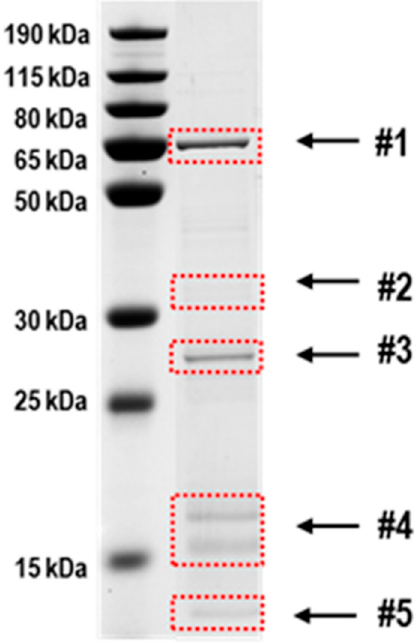
Figure 6. SDS-PAGE profile of the captured proteins by AbxC-affinity chromatography. AbxC was immobilized on CNBr- activated Sepharose 4B resin, incubated with D. radiodurans cell lysates, and washed with NaCl-containing buffer. Proteins captured by AbxC were released by 10 mM DTT and then separated on SDS-PAGE. Protein bands were identified after tryptic digestion by mass spectrometry. Table 1 is a complete list of protein